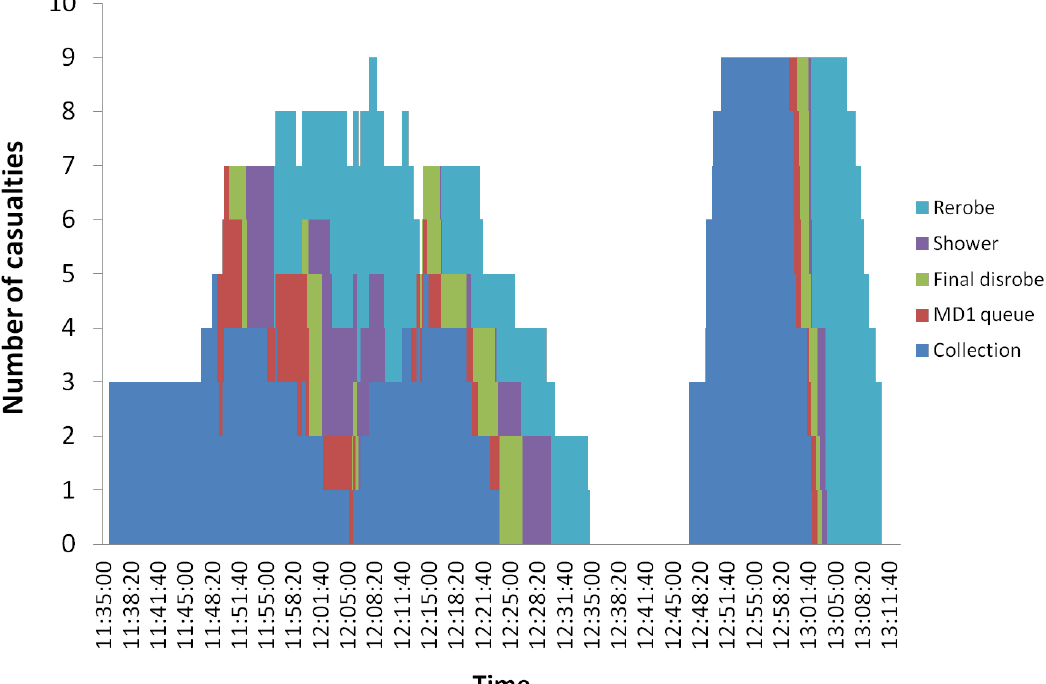
Figure A10. 25 male ambulant casualties passed through as described in the caption of Figure A9. 11 different groups entered the MD1 giving an average group size of 2.3 (range = {1,5}). 9 casualties (36%) spent less than 30 seconds in the shower. For a period of approximately 3 minutes the re-robe section contained 9 casualties, 4 greater than the intended capacity of 5. At approximately 12:30 the flow control system stopped working which may have resulted in the approximate 20 minute time gap in processing